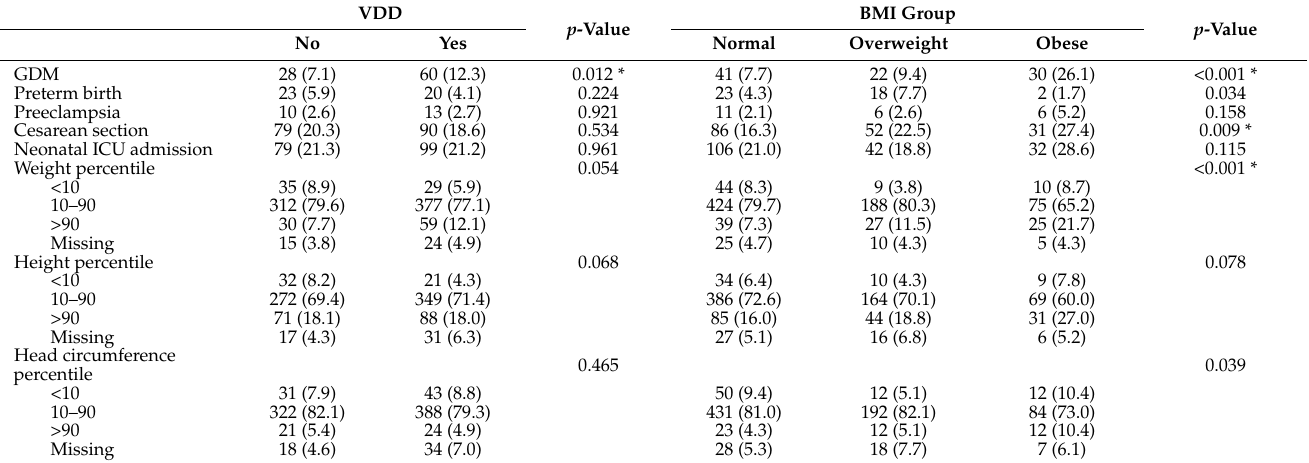
Table 3. Secondary maternal and neonatal events: Associations with VDD and BMI.